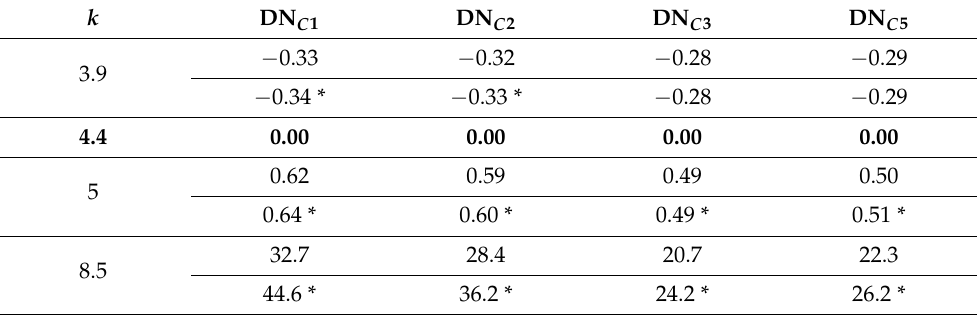
Table 2. Estimated degrees of leaf spring durability increase when using a material with different fatigue characteristics compared to the base material ( k *= 4.4 = k ).